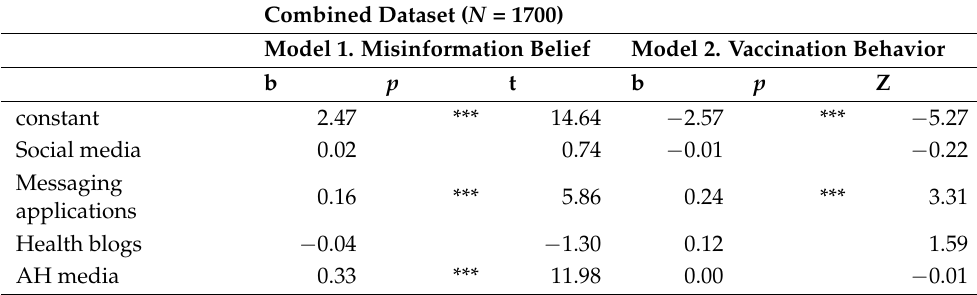
Table A8. Regression models of the main direct effects (adding “reliance on health